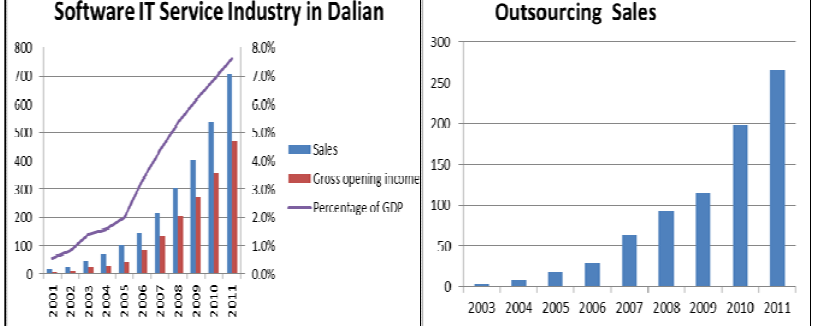
Figure 1. Basic figures of Dalian’s software and IT service industry Note: Unit: Hundred million Chinese yuan Source: Created by the author from Dairenshi Joho Sangyokyoku & Dairenshi Sofutouea Kyokai